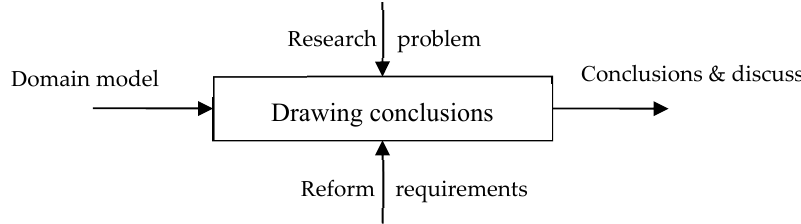
Figure 11. Inputs and output of analysis process of drawing conclusions.